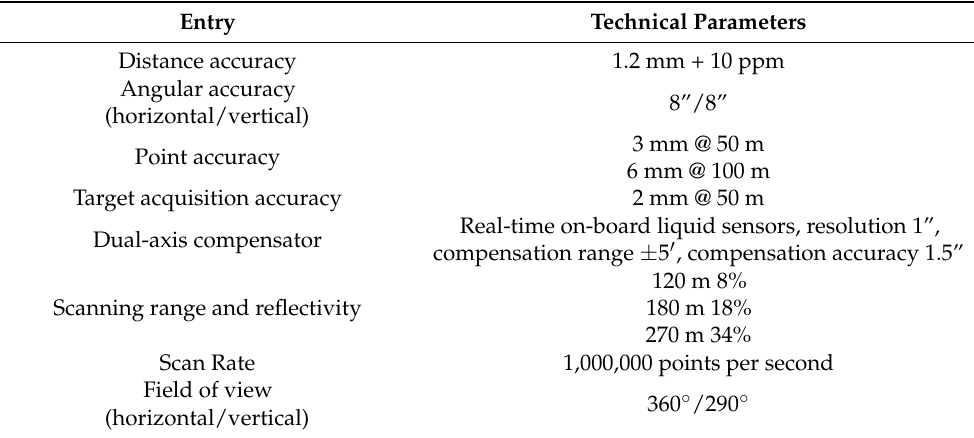
Table 1. Technical parameters of Leica ScanStaton P40.